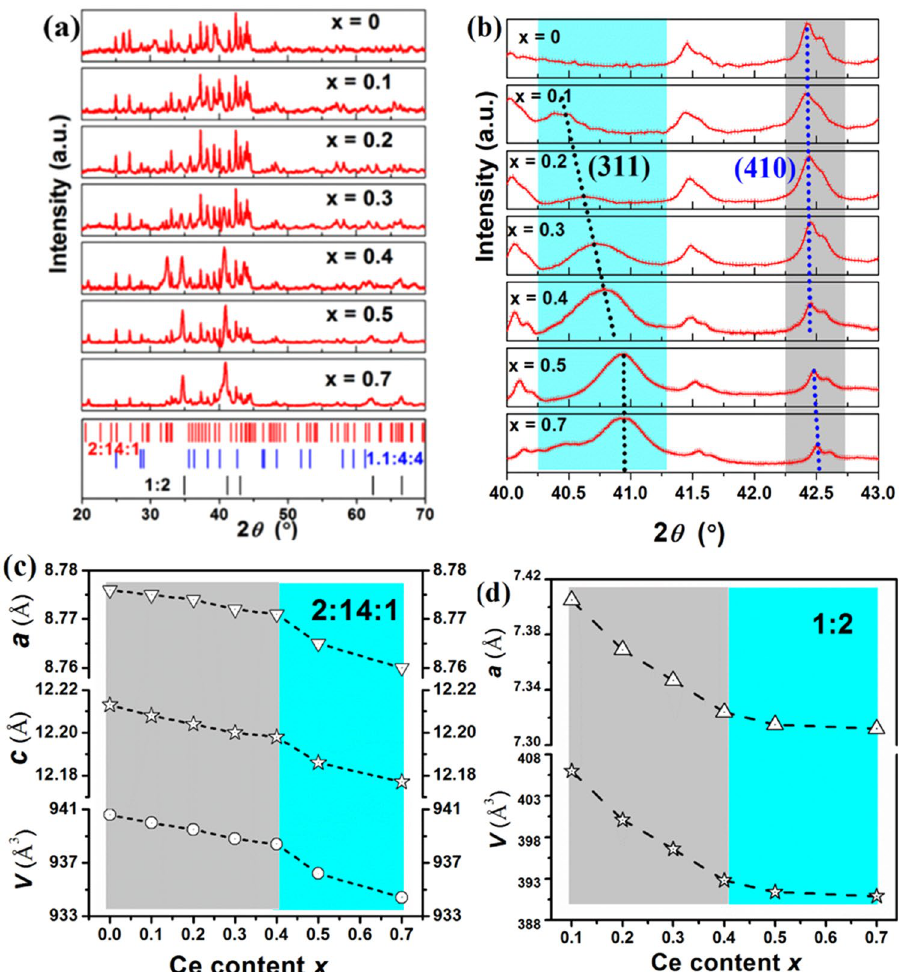
Figure 1. XRD patterns for the as-cast (Nd 1 − x Ce x ) 25 Fe 40 Co 20 Al 4 B 11 alloys ( a ), the enlarged patterns in the range of 40–43° ( b ), and the calculated cell parameters of 2:14:1 phase ( c ) and 1:2 phase ( d ) changed with Ce content x